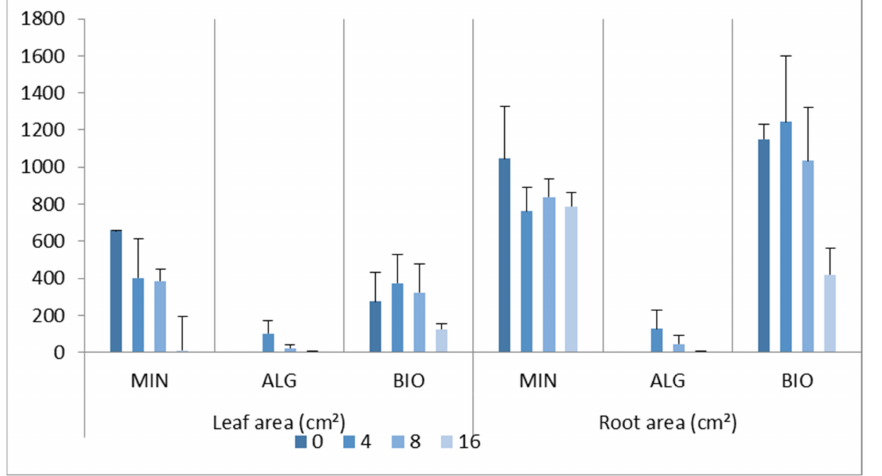
Figure 2. The effects of salinity stress and fertilizer types on five measured plant parameters during the early growth stage (7 weeks) for Rehan barley cultivar (MIN: mineral fertilization, BIO: biochar with mineral fertilization, ALG: dried algae biomass powder from freshwater (0, 4, 8, 16 mS/cm EC: the salinity concentrations in soil). No. = number, Avg. = average. The mean value and standard deviation are shown.